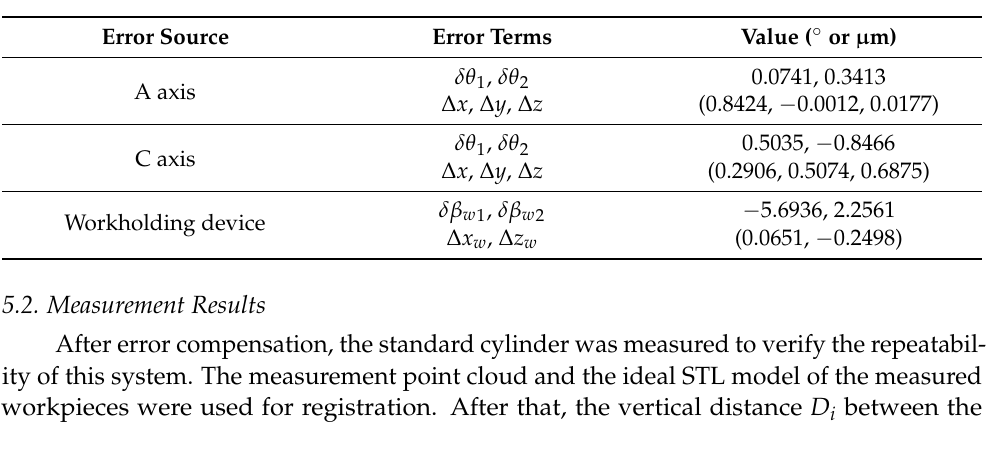
Table 3. The calibration results of the major error terms.